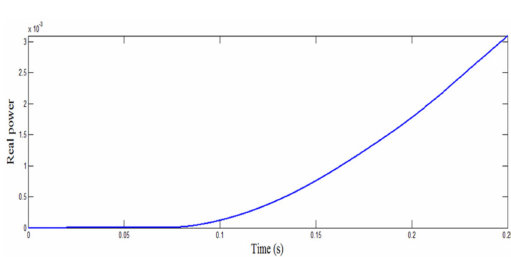
Figure 16. Reactive power from generation.